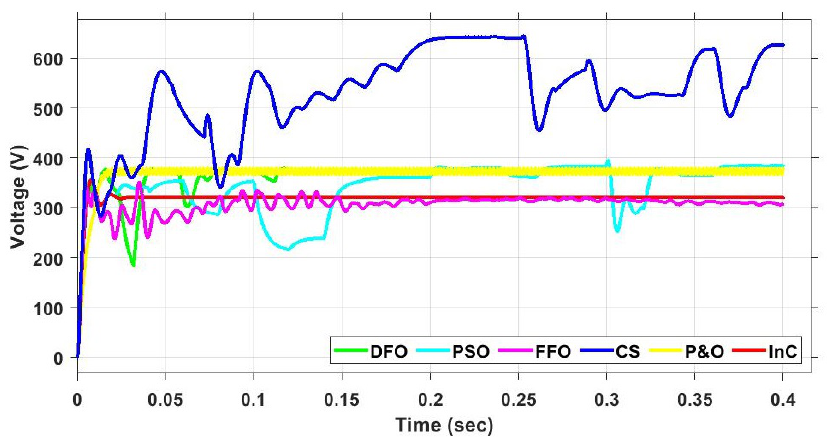
Figure 36. UI voltage comparison between all algorithms for MLPE Distributed PV